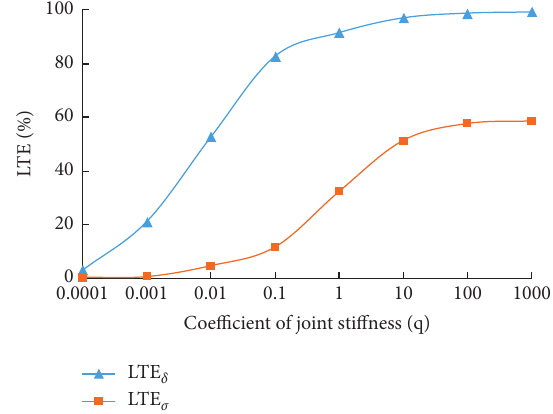
Figure 8: Relationship between coefficient of joint stiffness q and two LTEs in intact pavement.